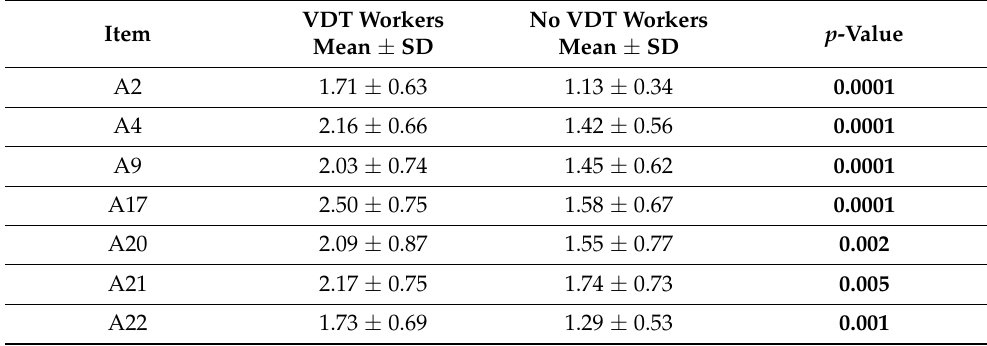
Table 3. Validity of the CVSS17 items: p -valuecomparison of the item scores between VDT workers and not (bold font: statistically